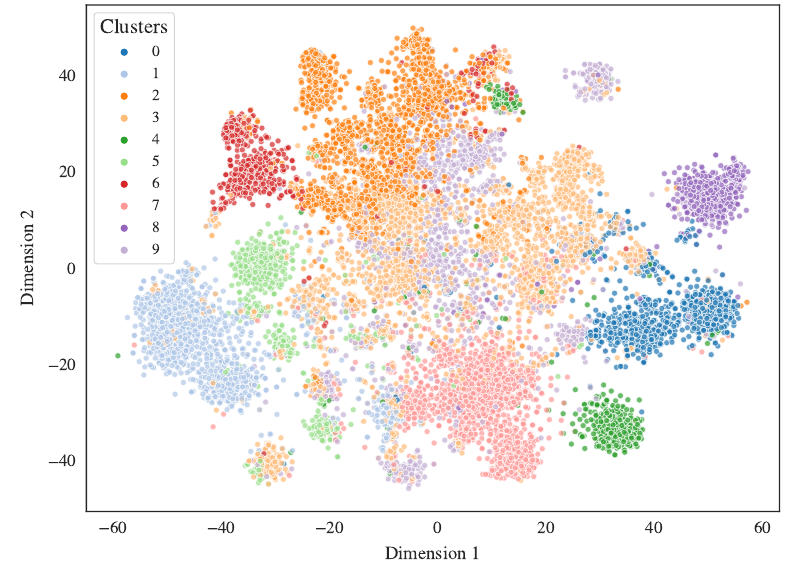
Figure 3. t-SNE visualization of K-means clustering results with 10